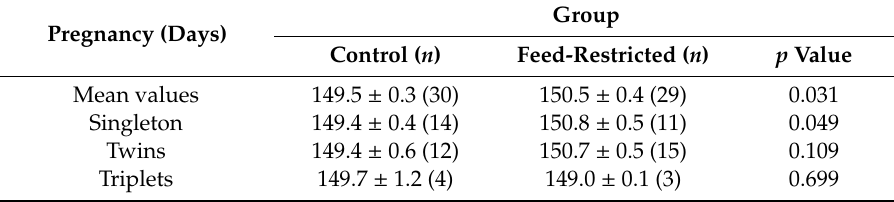
Table 2. Duration of pregnancy in feed-restricted and control ewes (mean ± SEM).